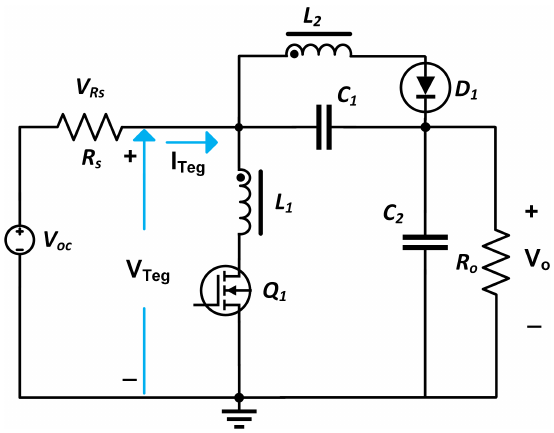
Figure 2. Converter used for